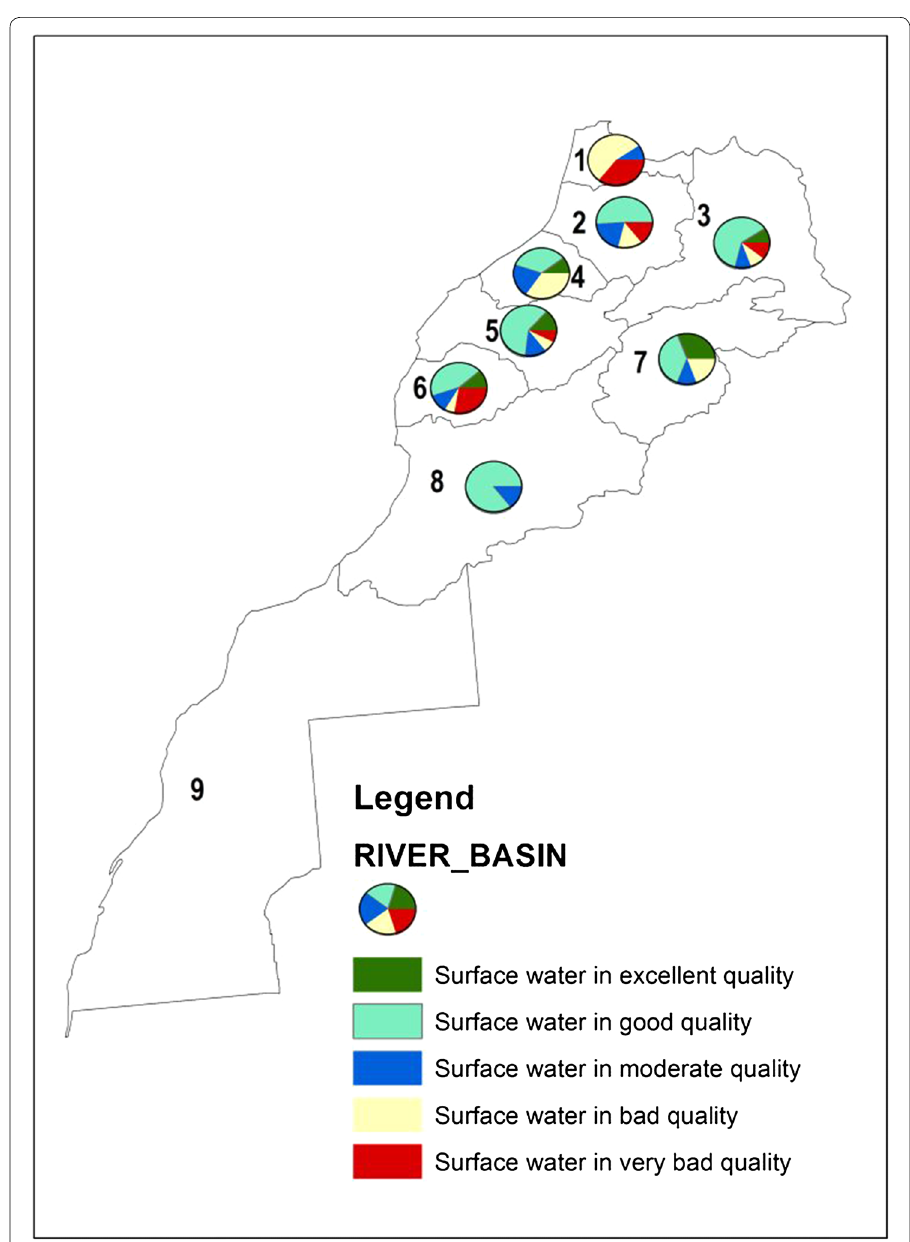
Fig. 2 Surface water resources quality. Source : created by the authors with data extracted from MEMWE report